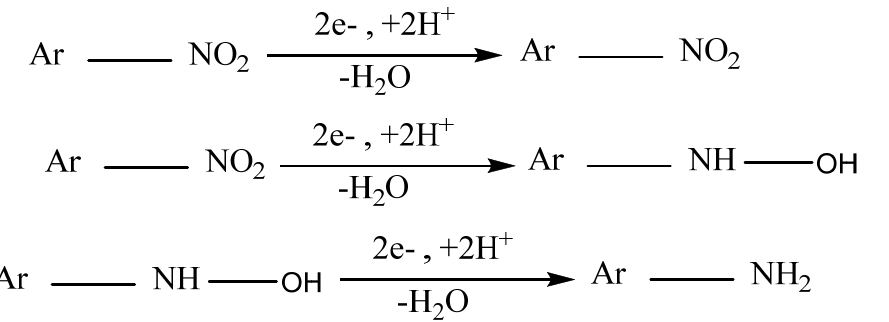
Figure 21. Illustration process of the reaction involved in the formation of aromatic amine from the reduction of aromatic nitro group.